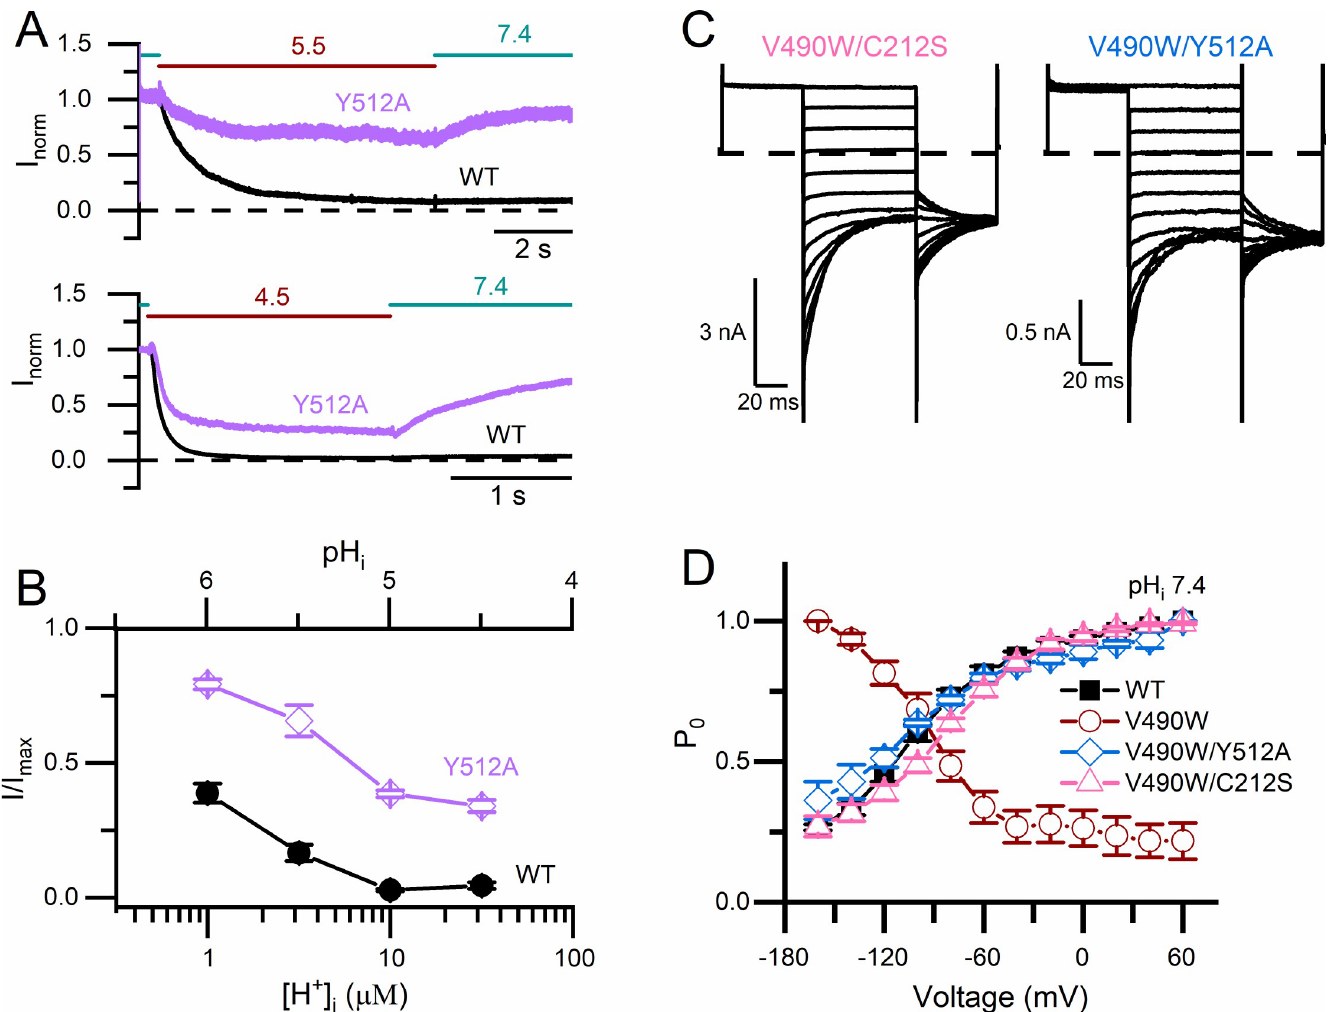
Fig 9. Correcting the inverted voltage-dependent opening in the V490W mutant by mutations that inhibit slow-gate closure. (A) Comparing the inhibitions of WT CLC-0 and the Y512A mutant by solutions with pH i = 5.5 (upper panel) and 4.5 (lower panel). (B) Remaining current fractions of WT CLC-0 and the Y512A mutant after the current inhibition by various [H + ] i (n = 5–6). (C) Recording traces of the double mutants V490W/C212S (left) and V490W/Y512A (right) obtained using the experimental protocol I with the tail step voltage at -100 mV. In both recordings, pH i = 7.4. (D) Relative P o of WT CLC-0, three mutants, C212S, V490W/ C212S and V490W/Y512A. All data were obtained at pH i = 7.4 (n = 3).